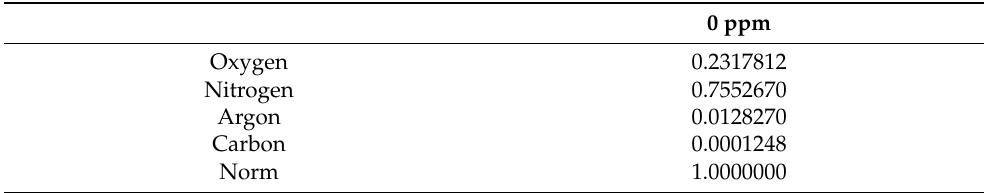
Table 2. Air composition sample tank (0 ppm